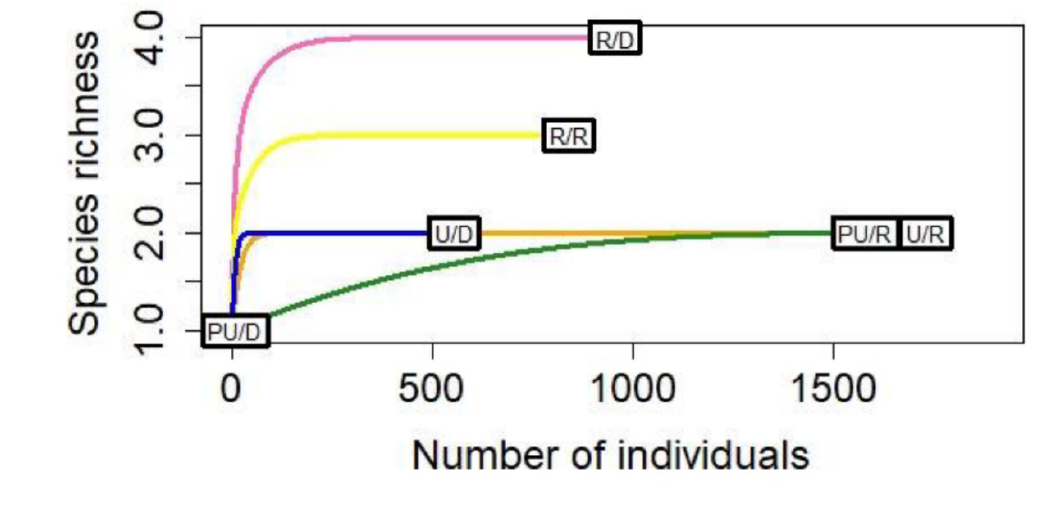
Figure 2. Rarefaction curves comparing Aedes mosquito abundance and species richness per season in each habitat type.